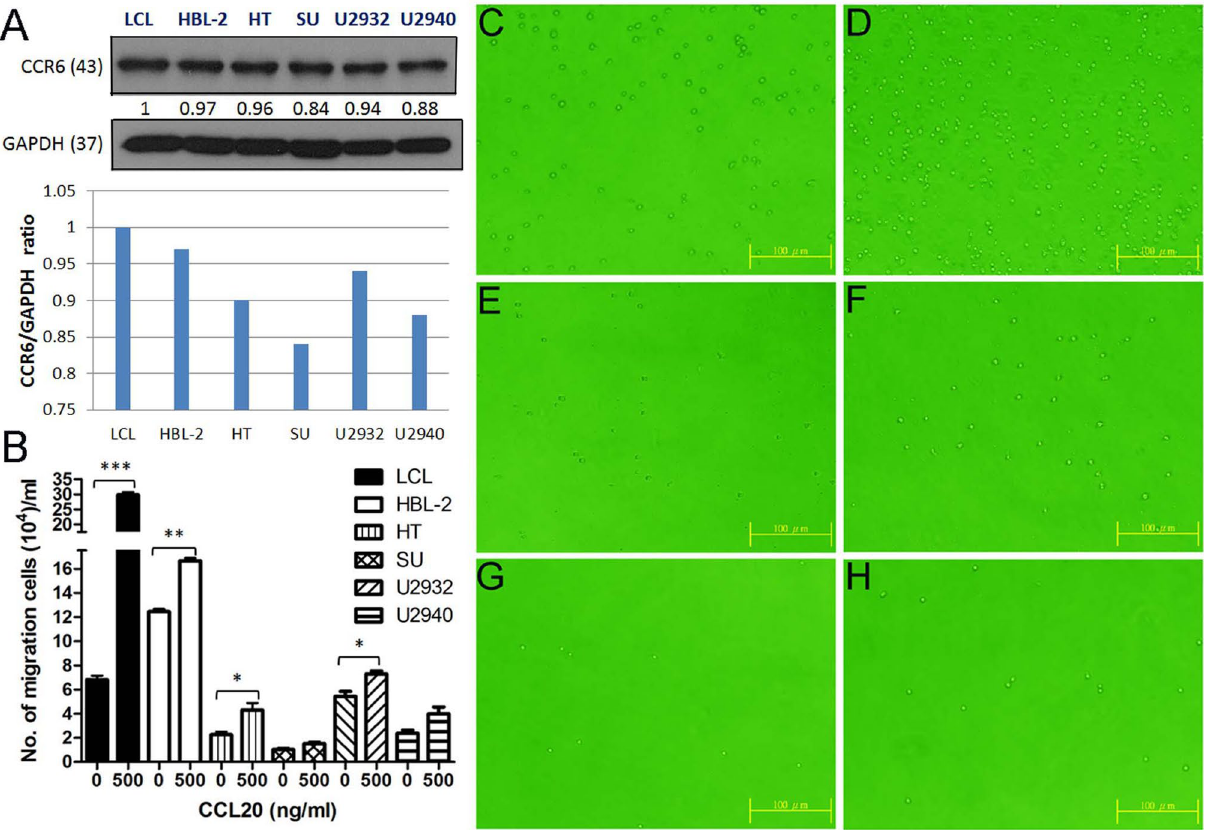
Figure 6. B cells with higher CCR6 expression have higher chemotactic ability. ( A ) Relative expression levels of CCR6 protein in six B cell lines. ( B ) Chemotaxis assay shows that B cells with higher CCR6 expression have higher chemotactic migration ability for CCL20. ( C–H ) Examples of cell migration (C, E, G: 0 ng/mL of CCL20; D, F, H: 500 ng/mL of CCL20; C-D: LCL; E–F: HT; G-H: SU-DHL-5). * p < 0.05, ** p < 0.01, *** p < 0.001, Student paired t